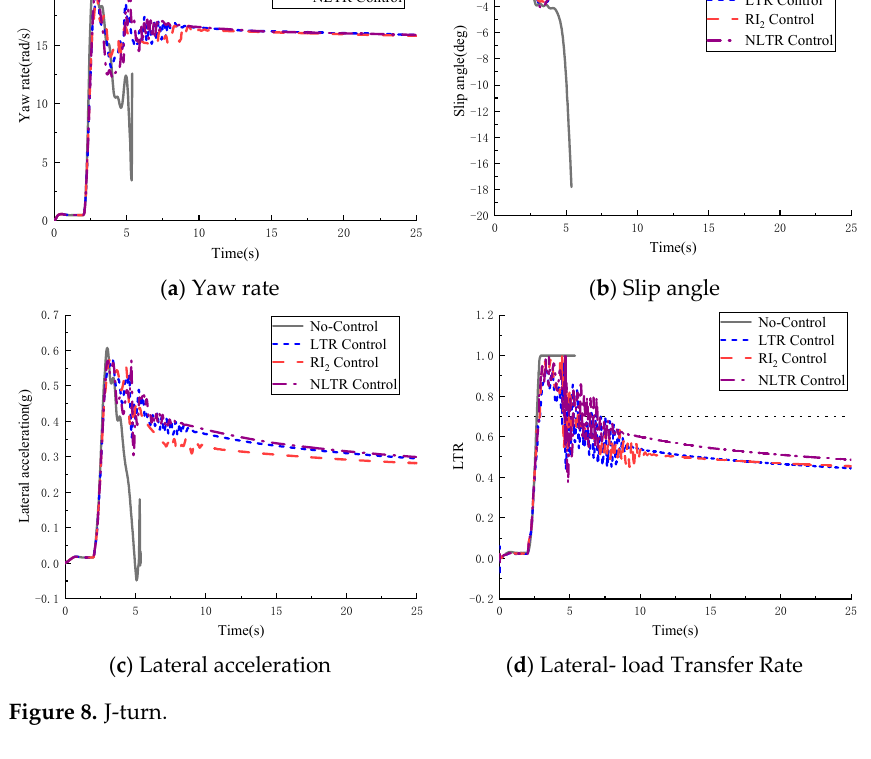
Figure 8. J-turn.